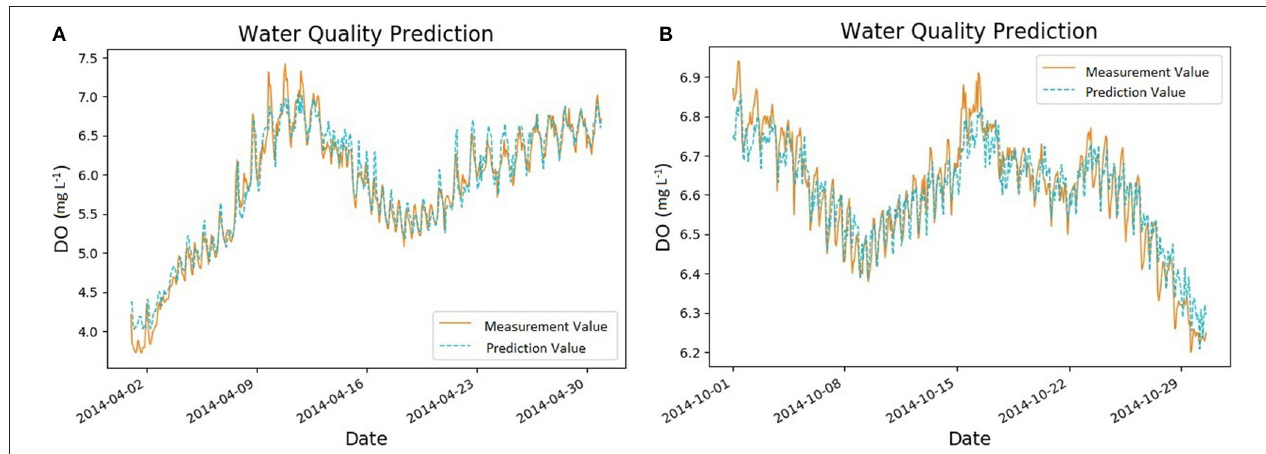
FIGURE 7 | DO prediction in both the wet and dry seasons. (A) 90 min ahead DO prediction in the wet season (1/4/2014-30/4/2014). (B) 90 min ahead DO prediction in the dry season (1/10/2014-31/10/2014).